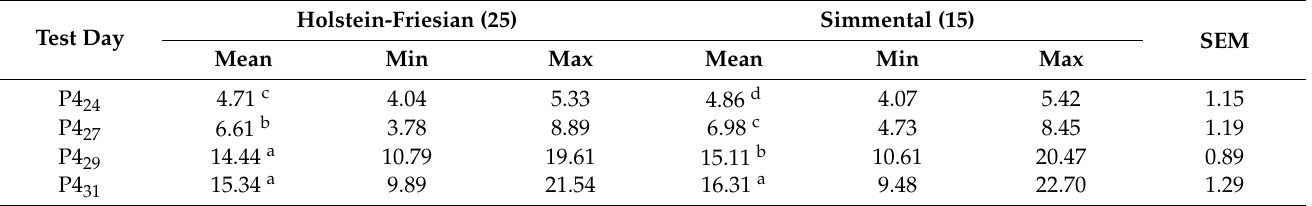
Table 2. Changes in ovarian activity assessed on the basis of progesterone (P4) content in milk (ng/mL) on successive